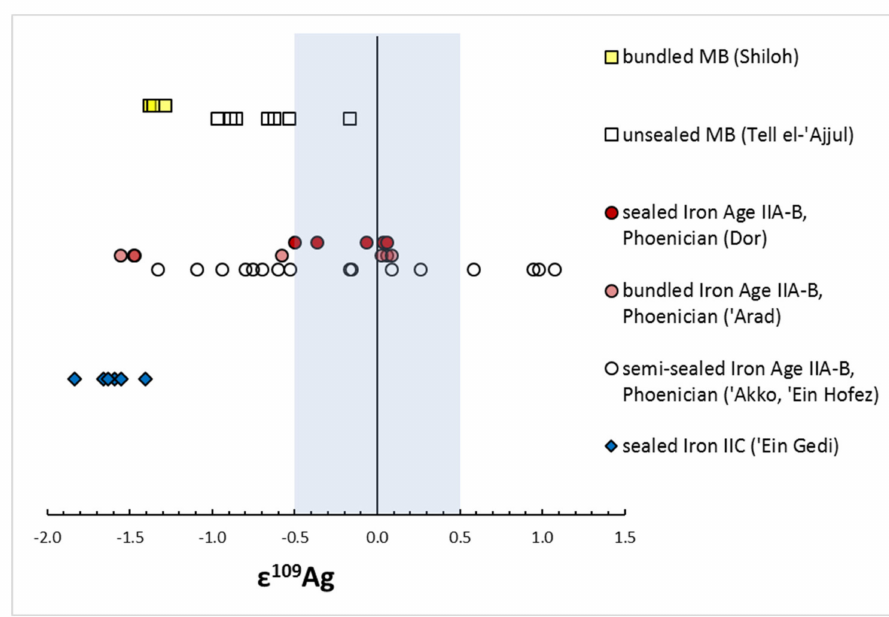
Figure 5. Ag isotopic composition of sealed and unsealed silver. The results are marked according to time periods: Squares—Middle/Late Bronze Age transition; Circles—Iron Age IIA–B (Phoenician); Rhombuses—Iron Age IIC. Color indicates sealed